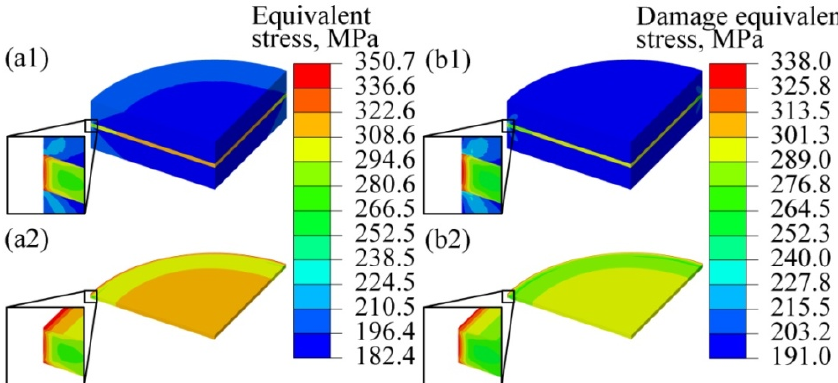
Figure 4. Simulation results of the von Mises equivalent stress and the damage equivalent stress: von Mises equivalent stress in the ( a1 ) TLP bonded joint and ( a2 ) intermediate layer, and damage equivalent stress in the ( b1 ) TLP bonded joint and ( b2 ) intermediate layer.